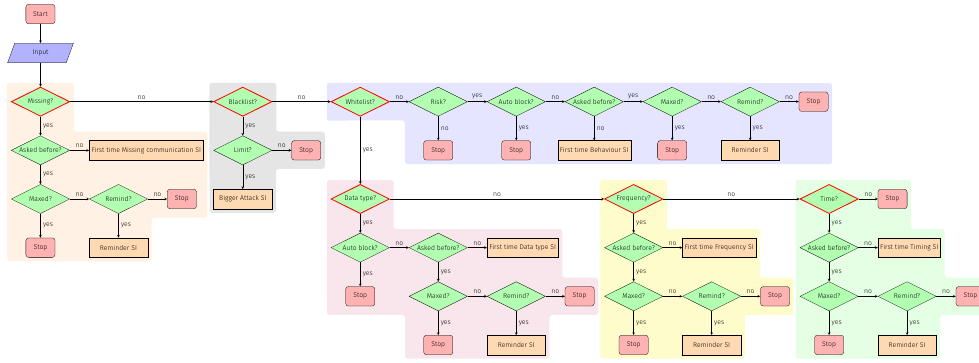
Figure 2. Decision tree conceptualisation with coloured highlighting of the main branches.